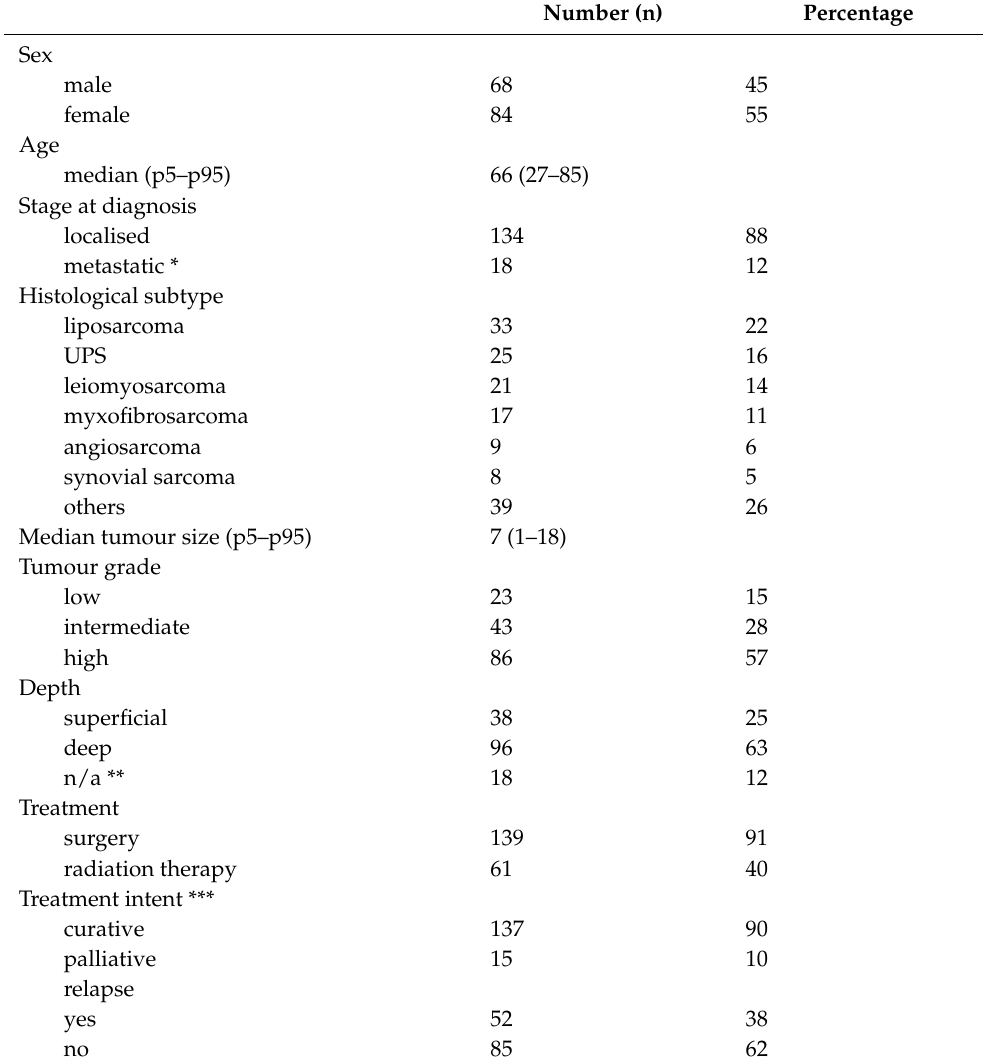
Table 1. Patient, tumour, and treatment